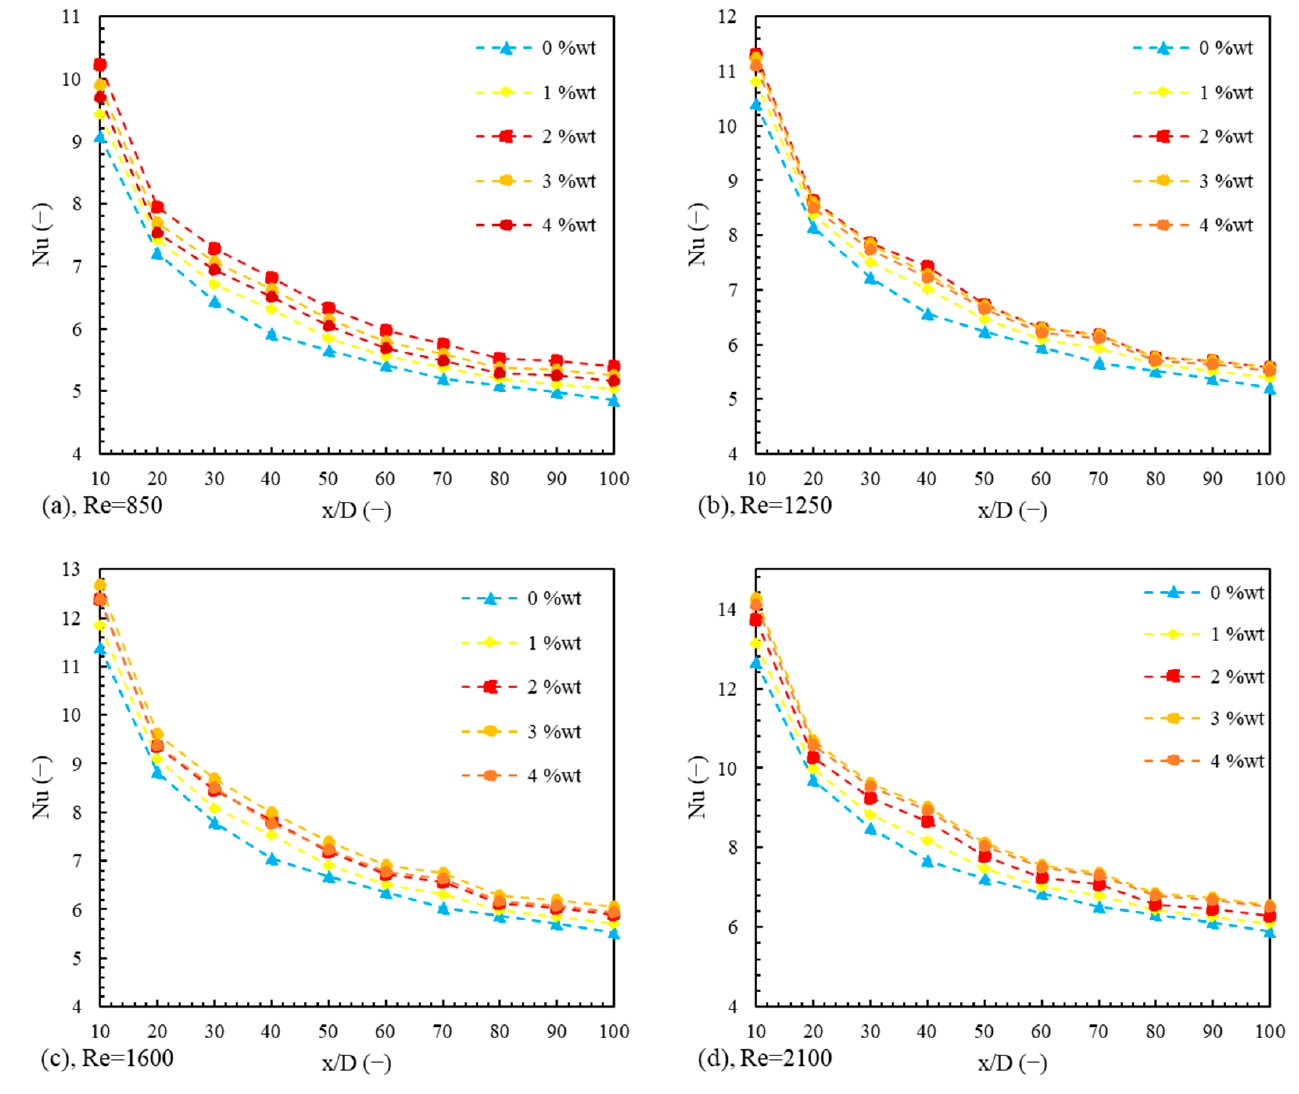
Figure 8. The results of local Nu for circular cross-section with different nanoparticle concentrations in ( a ) Re = 850, ( b ) Re = 1250, ( c ) Re = 1600, and ( d ) Re = 2100.